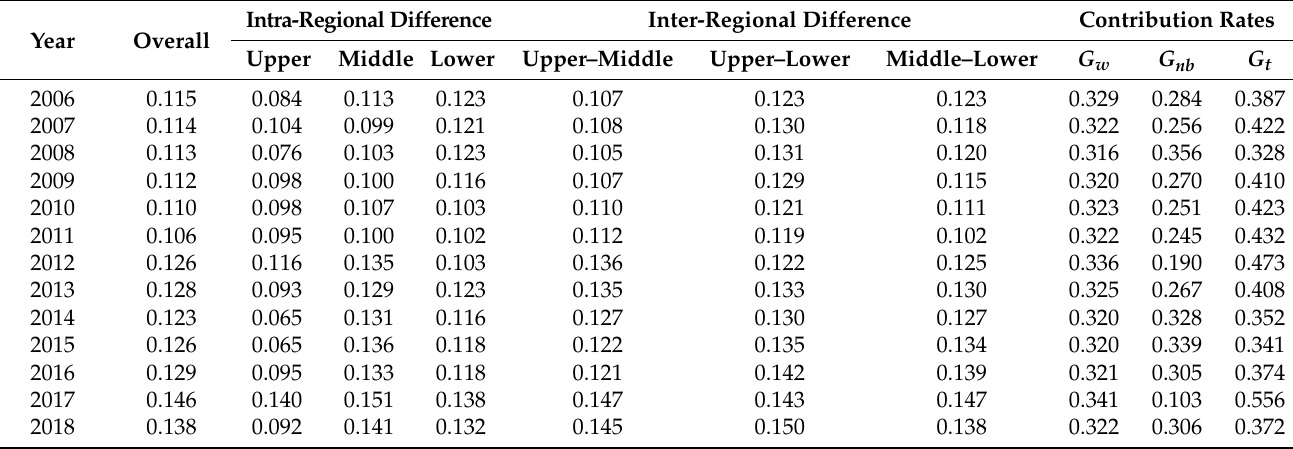
Table 6. Dagum’s Gini coefficient and its decomposition